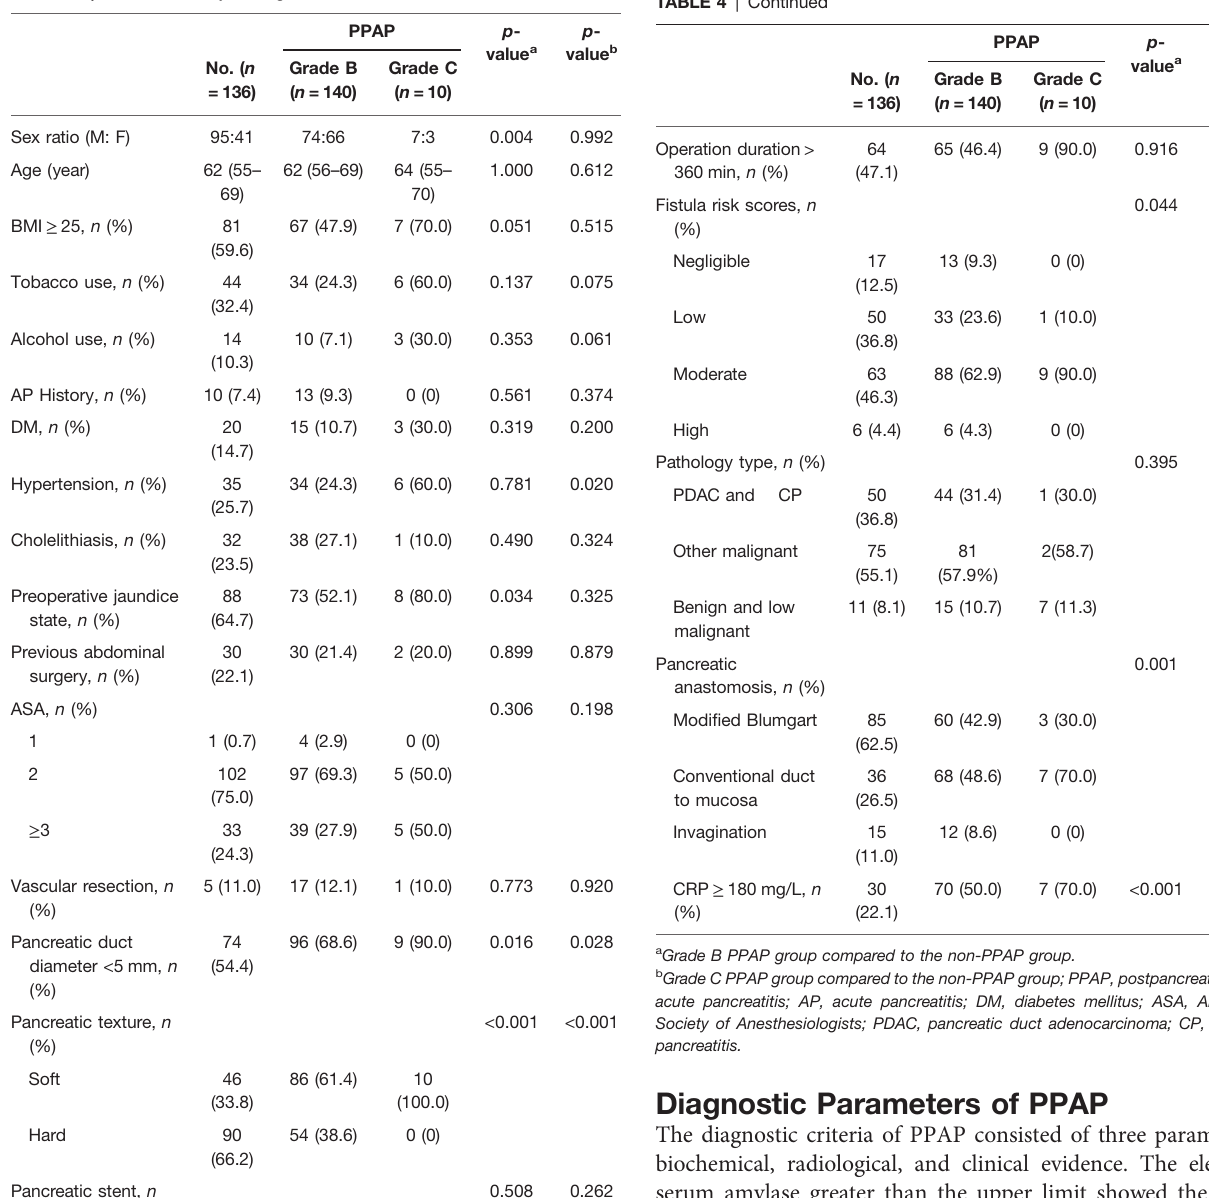
TABLE 4 | Univariate analysis of grade C